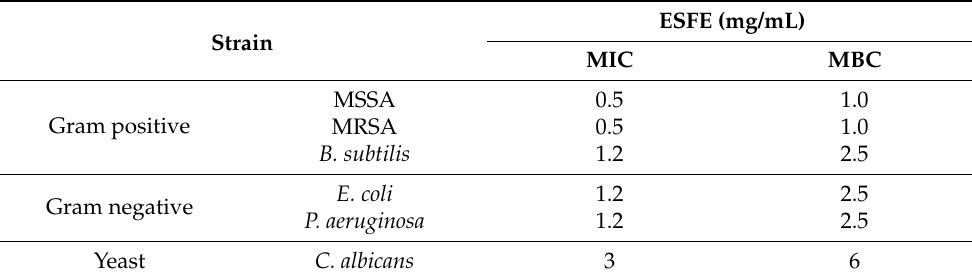
Table 2. MIC and MBC of ESFE against the tested organisms.